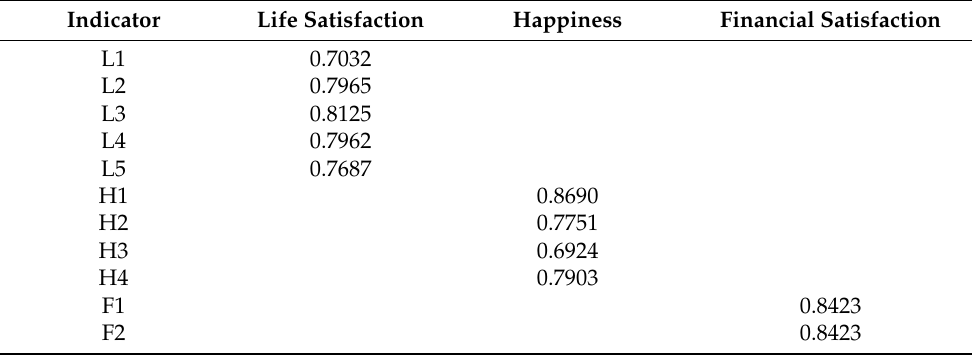
Table 2. Loadings.